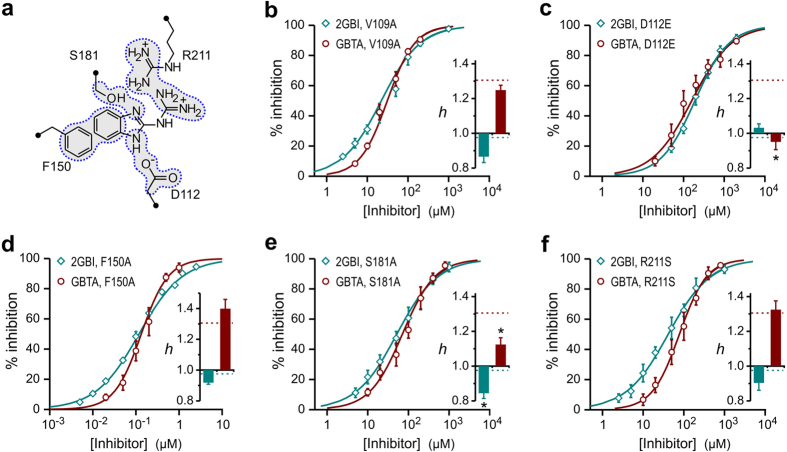
GBTA binding cooperativity is modified by perturbations of the binding site.(a) Hv1 residues proposed to be involved in the binding of guanidine derivatives. Dotted blue curves encircle side chains previously proposed to interact with different parts of compound 2GBI29. (b–f) Concentration dependences of inhibition of the indicated Hv1 mutants by compounds 2GBI (teal) and GBTA (dark red). Each point represents the average inhibition from 3 to 12 measurements ± S.D. V109 served as a negative control. Curve lines are Hill fits used to obtain apparent Kd values (see Supplementary Table 1). Hill coefficients (h) shown in inset histograms were determined from fits reported in Supplementary Figs 3 and 4. Reference h values for Hv1 WT are shown as dotted lines. Asterisk indicates statistically significant difference between mutant and WT channel (p < 0.05/14, see methods).